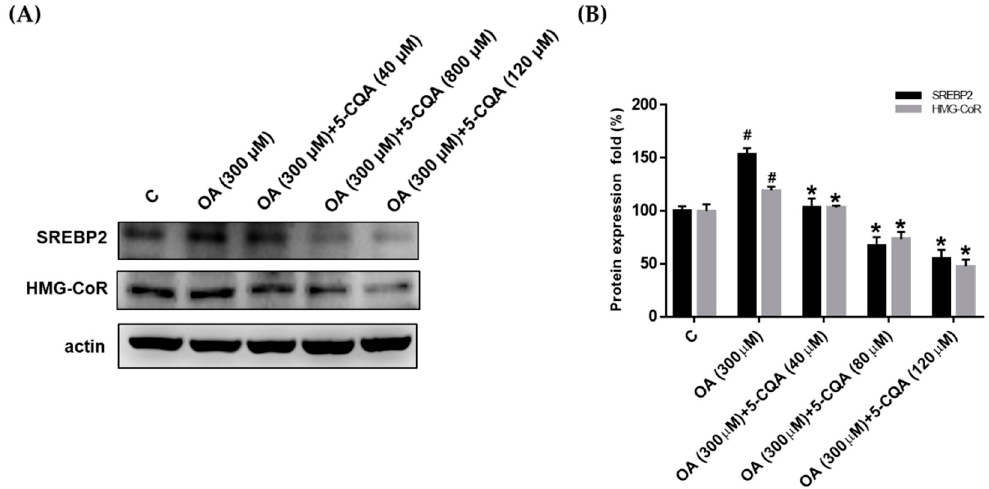
Figure 4. 5-CQA decreased the expression of enzymes involved in cholesterol synthesis. ( A ) Cultured cells were treated with OA with or without 5-CQA (40, 80, or 120 µ M) for 24 h. Protein expression was detected using Western blot analysis against SREBP2 and HMG-CoR antibodies, with anti-actin as the internal control. ( B ) The data are represented as mean ± SD from three samples for each group. # p < 0.05, in relation to the control group. * p < 0.05, in relation to the OA-induced group.